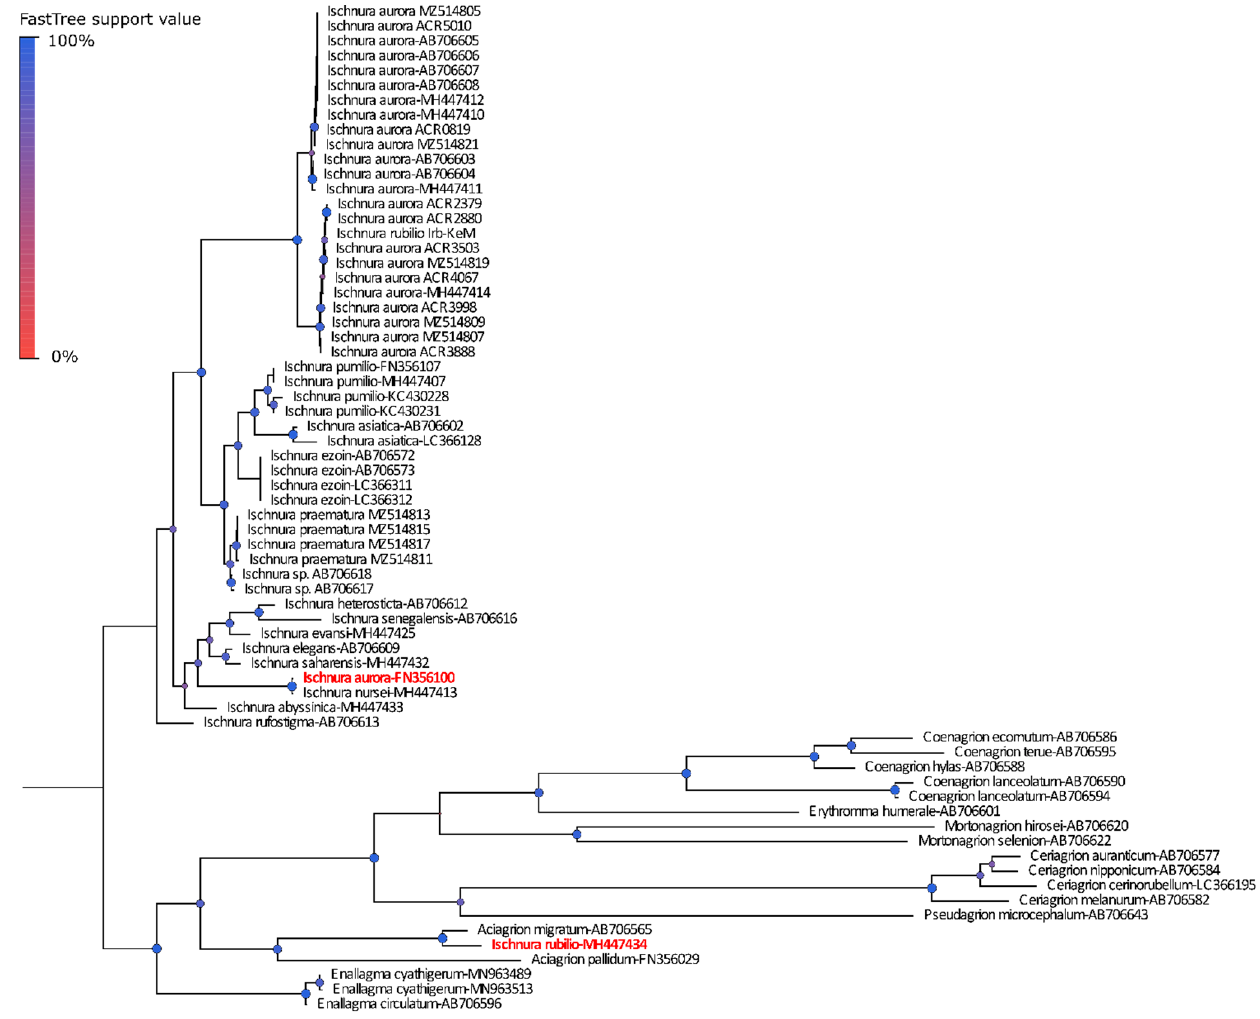
Figure A1. Maximum likelihood tree obtained with FastTree 2.1.11 for the ITS dataset (68 sequences; 655 bp-long). Highlighted in red are the two sequences downloaded from GenBank that were finally excluded from our dataset. The coloured dots on the nodes represent FastTree support values according to the legend on the left.